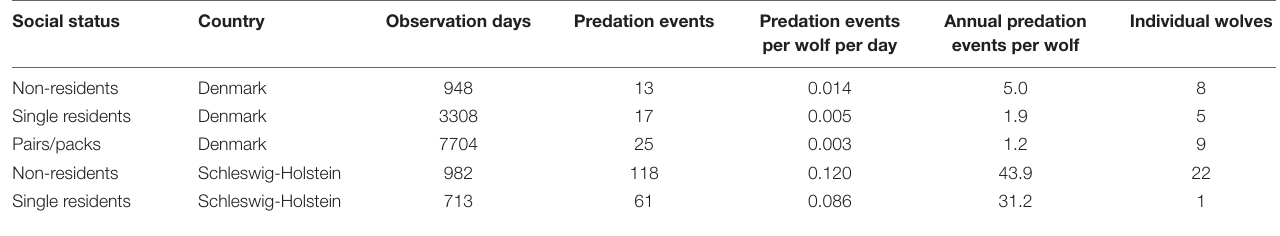
FIGURE 3 | (A) Distribution of 565 livestock depredation events in Jutland peninsula attributed to wolves by state authorities, 2013–August 2021. (B) The sheep density (number of individuals per ha) per grid cell in Jutland peninsula. The black line represents the border between Denmark in the north and Schleswig-Holstein in the south. TABLE 2 | The number of individual wolf observation days (of identified individuals), livestock depredation events (number, events per day, events per year), and number of individuals from January 2017 to August 2021 separately for non-residents, single residents, and pairs/packs in Denmark and